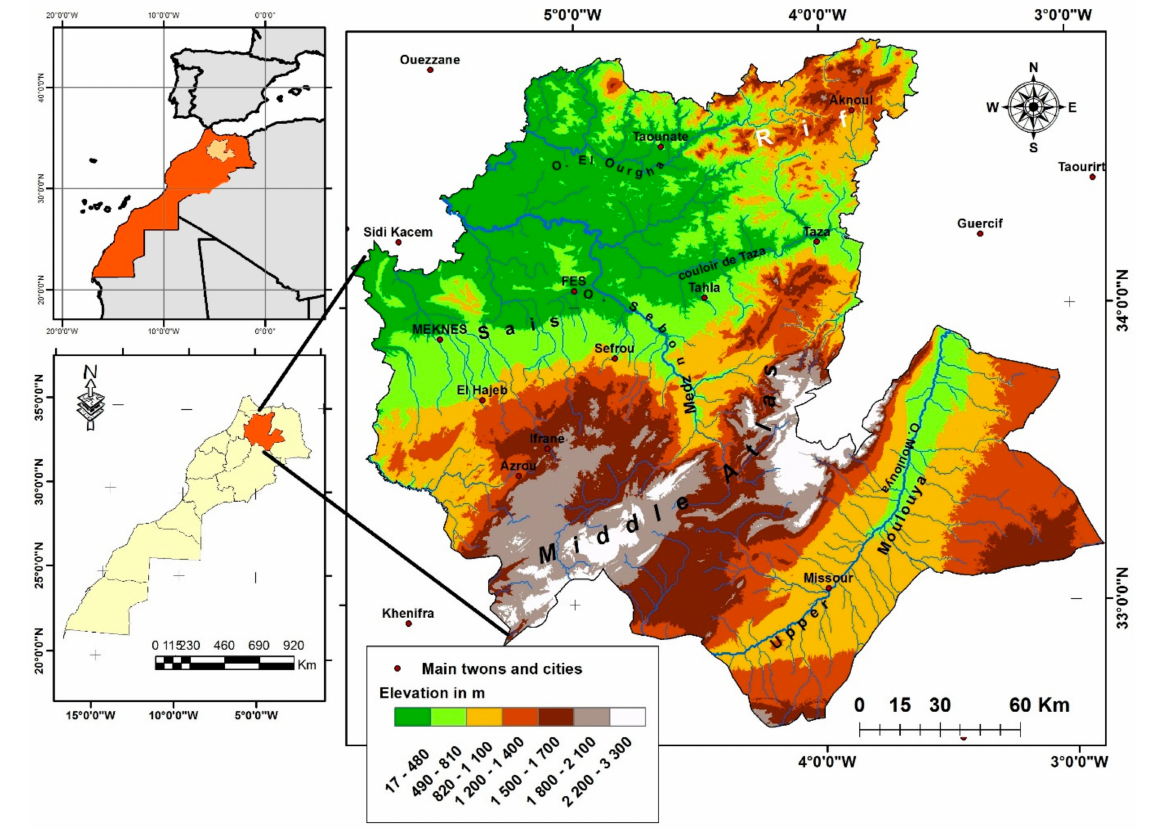
Figure 1. Geographical location of the Fez-Meknes